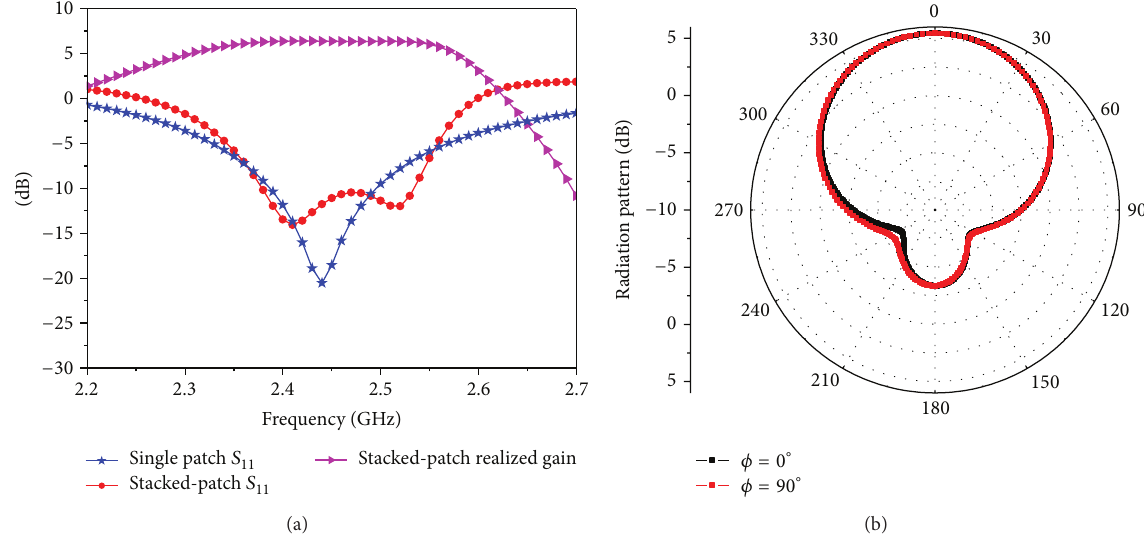
Figure 3: Simulated results of the proposed antenna. (a) 𝑆 11 characteristics including single patch and stacked-patch antennas, stacked-patch antenna’s realized gain in the broadside direction, and (b) radiation patterns at 2.45 GHz of stacked-patch antenna in 𝜙 = 0 ∘ and 𝜙 = 90 ∘